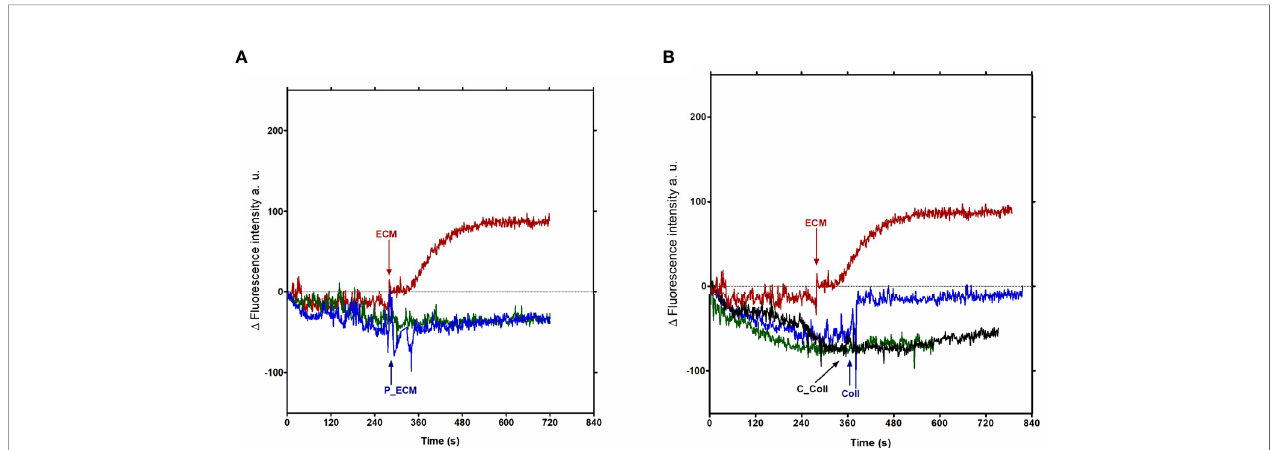
FIGURE 6 | Protein fraction of ECM is implicated in the calcium signal in trypomastigotes from T. cruzi . Total ECM (40 µg) and Collagen I (5 µg)-derived calcium signal. (A) red line: Ca 2+ concentrations measured in the presence of ECM; blue line: ECM previously treated with protease, followed by the addition of protease inhibitor (P-ECM); green line: Ty (trypomastigotes without ECM). (B) red line: Ca 2+ concentrations measured in the presence of ECM; blue line: Ca 2+ concentrations measured in the presence of 5 µg of Collagen I; black line: Ca 2+ concentrations measured in the presence of 5 µg of Collagen I treated with collagenase (C-Coll). The graph is representative of two independent